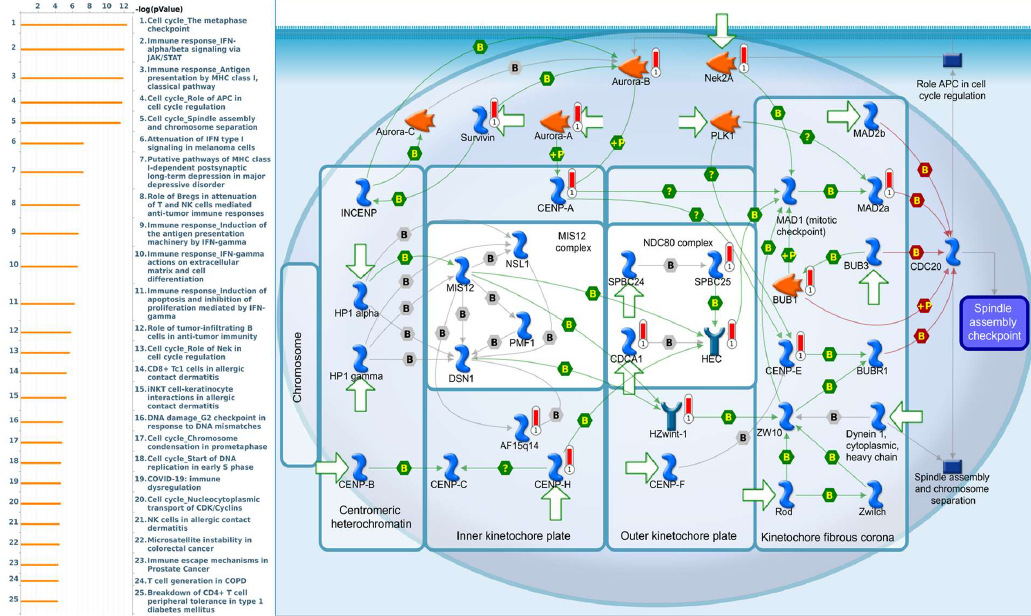
Figure 9. MetaCore pathway analysis of the coexpression gene network of proteasome 20S subunit alpha 5 (PSMA5) in breast cancer patients. We used the MetaCore platform to analyze genes coexpressed with PSMA5 from the associated METABRIC and TCGA datasets, and downstream pathway analyses revealed that “Cell cycle_The metaphase checkpoint” participates in breast cancer